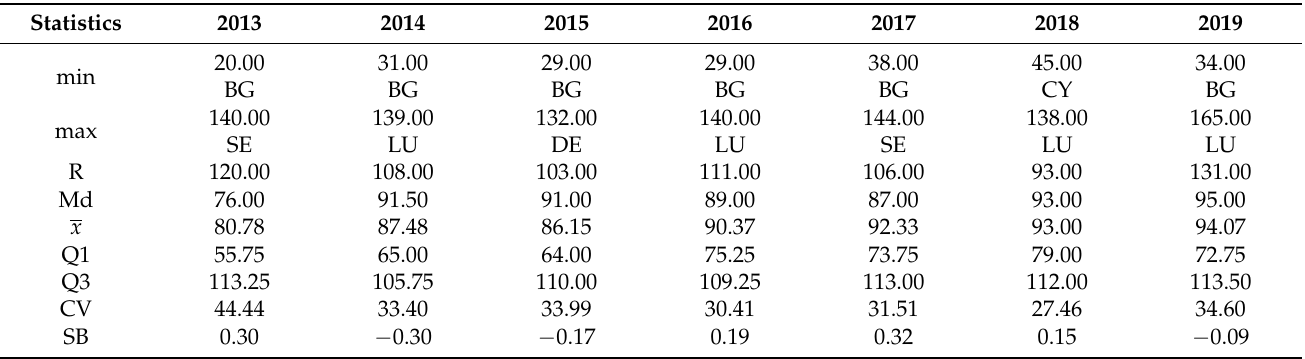
Table 1. Descriptive parameters of the Eco-Innovation Index for the European Union countries in the years 2013–2019 (EU average = 100).